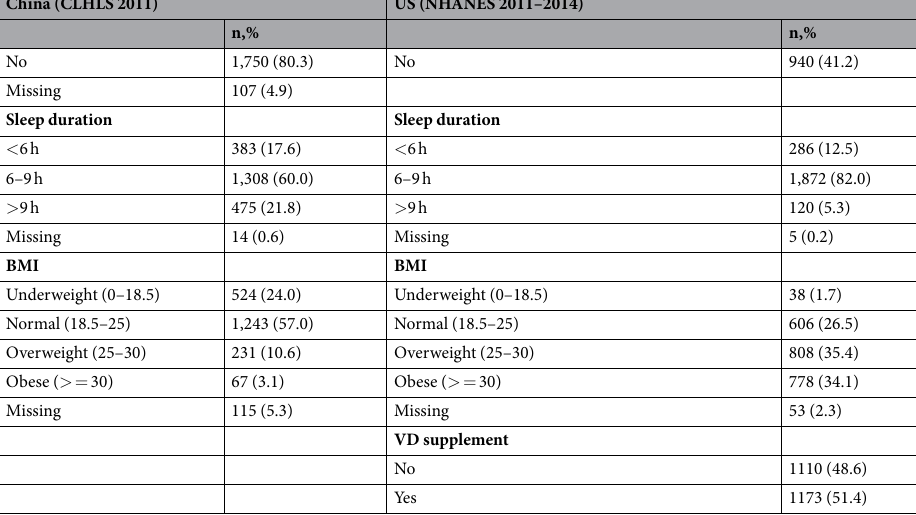
Table 1. Baseline characteristics of the CLHLS and NHANES